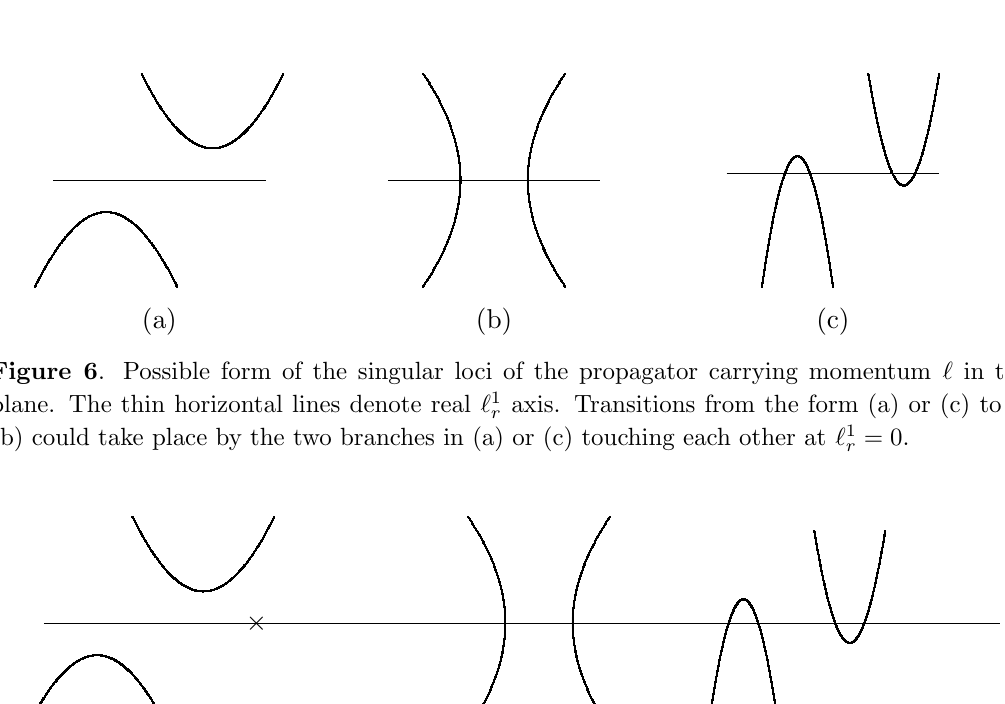
Figure 7 . This (cid:12)gure represents, for a given real value of k 1 denoted by (cid:2) , the singular loci in the s complex k 1 plane from di(cid:11)erent propagators at the end of the deformation described in section 3.1. s The thin horizontal line denotes real k 1 axis. As k 1 denoted by (cid:2) moves along the real axis, the s s shapes of the singular loci change so as to make way for the integration contour to pass all the way from (cid:0)1 to 1 without encountering a singular